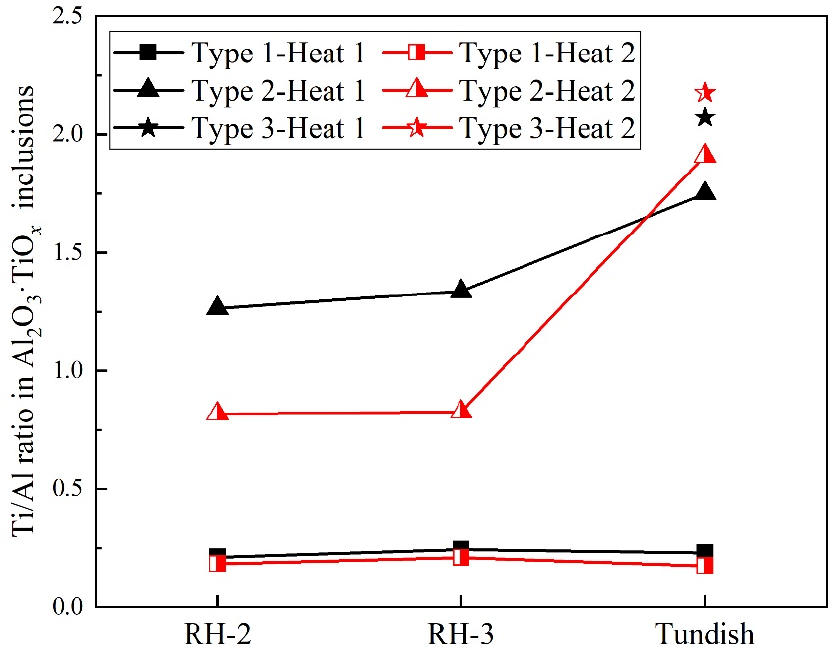
Figure 11. Ti/Al ratio in various Al 2 O 3 ·TiO x inclusions during RH treatment and tundish processes.